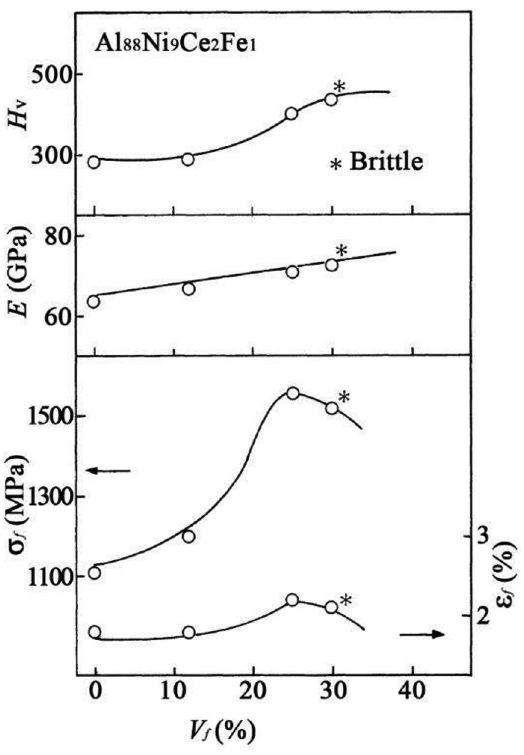
Figure 6. Hardness ( H (σ ) and fracture elongation (ε f fcc-Al phase (V